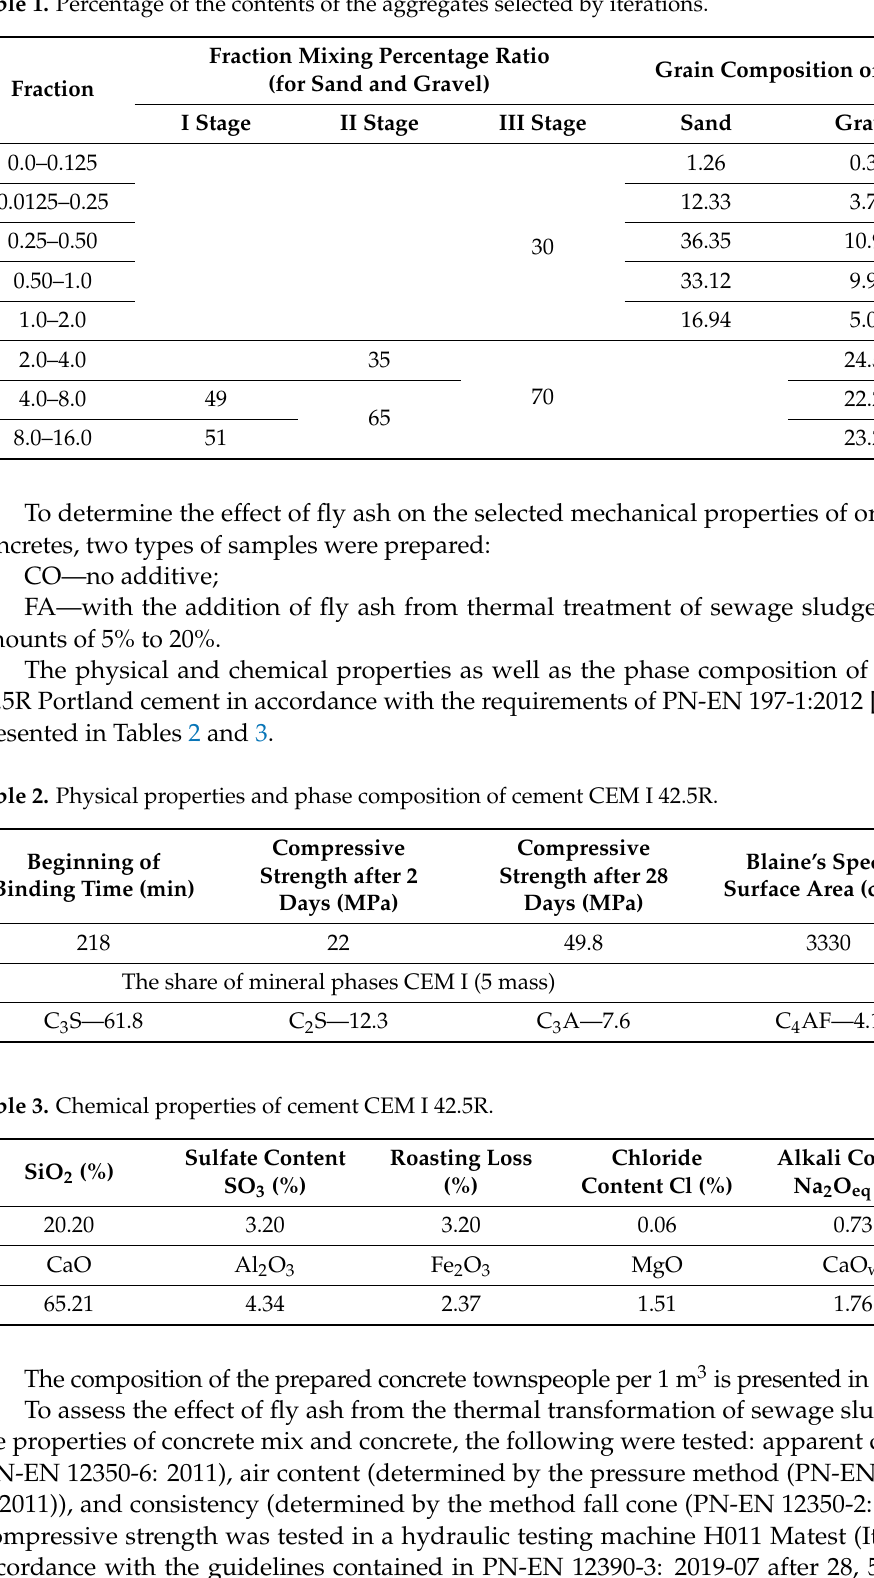
Table 1. Percentage of the contents of the aggregates selected by iterations.